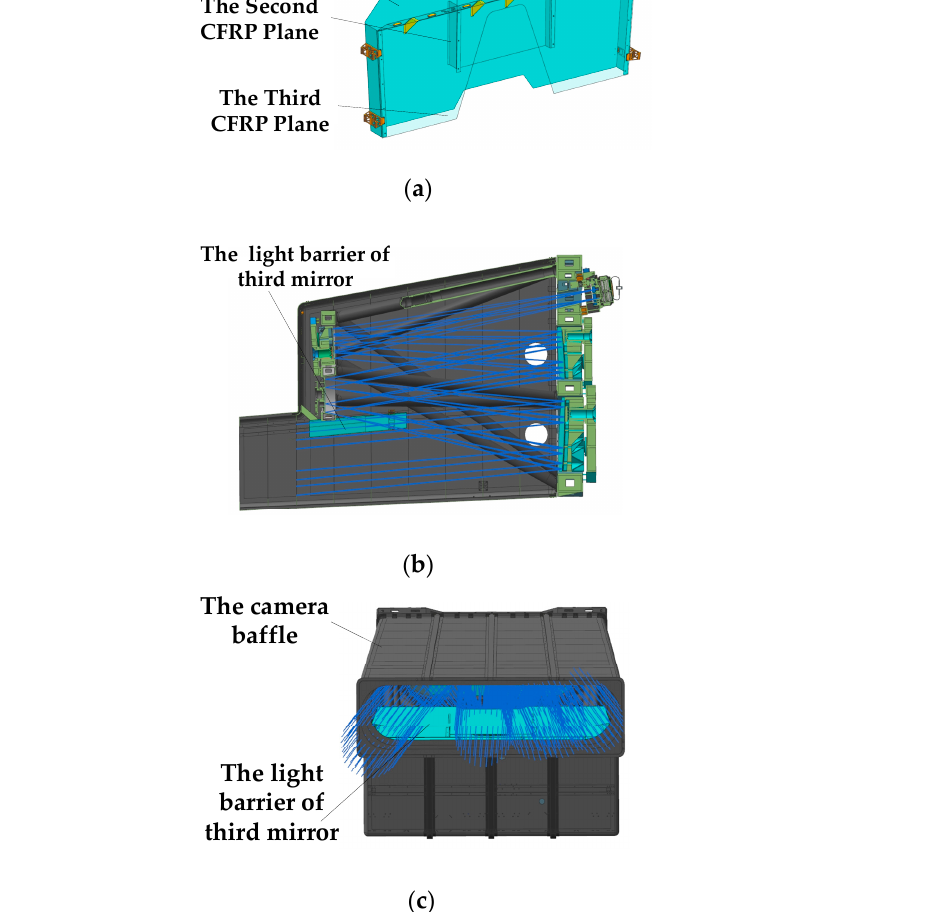
Figure 11. PST analysis curve of the system after installing the light barrier of the third mirror. Table 8. Simulation results of the VGI after installing the light barrier of the third mirror. Area Light Source Position